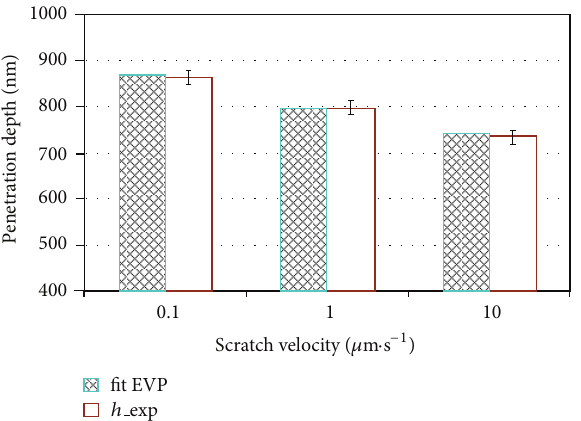
Figure 11: Comparison of experimental results ( ℎ exp) and numer- ical results (fit EVP) for 𝐹 𝑛 = 80 mN. The numerical results have been obtained with the elastic-viscoplastic model in using a Young modulus of 3.75 GPa. The set of parameters have been identified from experimental scratch results at 20mN.